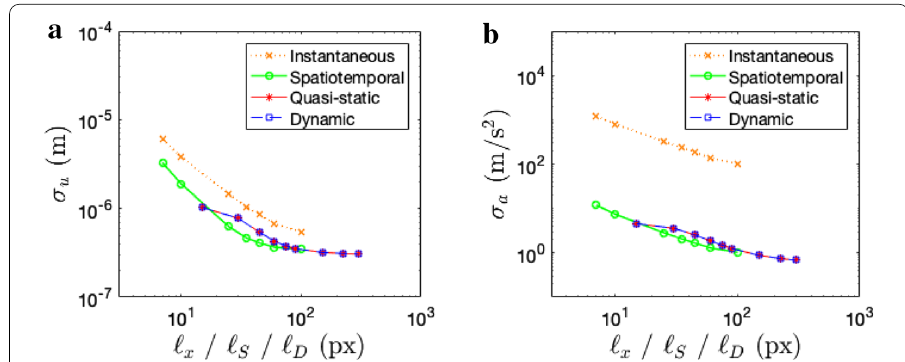
Fig. 2 Standard displacement ( a ) and acceleration ( b ) uncertainties as functions of the static ( (cid:8) S ) and dynamic ( (cid:8) D ) regularization lengths. Comparison with instantaneous and spatiotemporal analyses. The physical size of one pixel is 200 µ m. The same type of compromise between measurement uncertainty and spatial resolution is found in comparison with instantaneous and spatiotemporal DIC